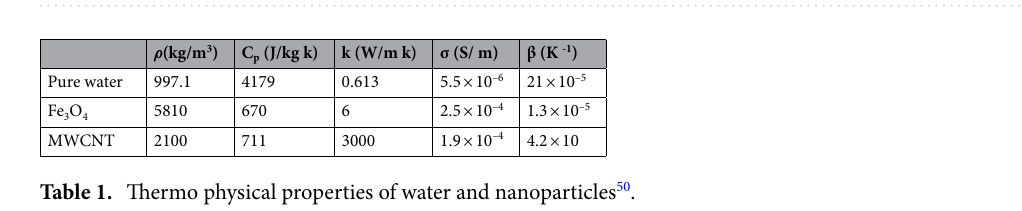
Figure 1. Schematic illustration of corrugated enclosure and sample mesh.